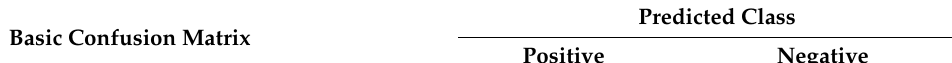
Table 3. The Basic Confusion